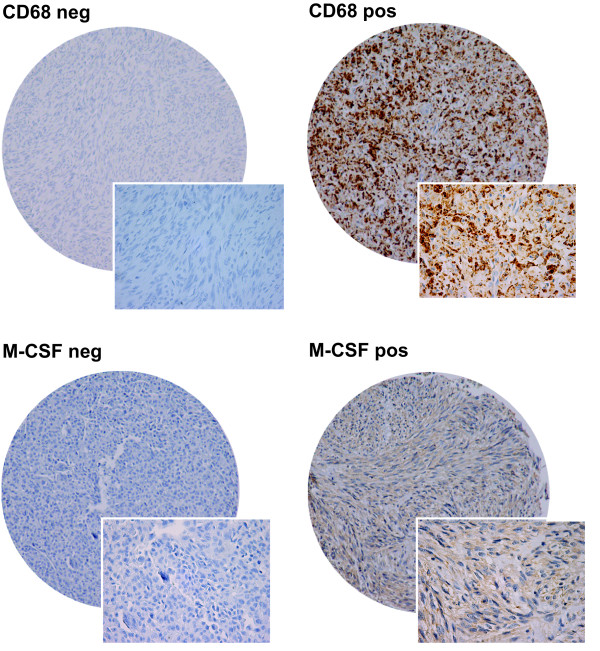
IHC microscopic pictures of TMA of soft tissue sarcoma representing different expression of CD68 and M-CSF. (A) CD68 low expression; (B) CD68 high expression; (C) M-CSF low expression; (D) M-CSF high expression. Original magnification X 100 and 400.